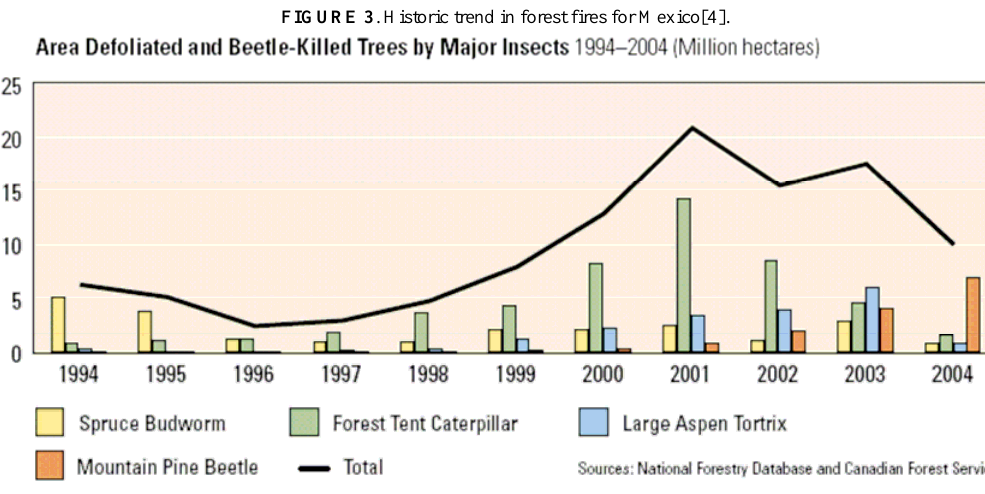
FIGURE 4 . Historic trends in forest pest activity in